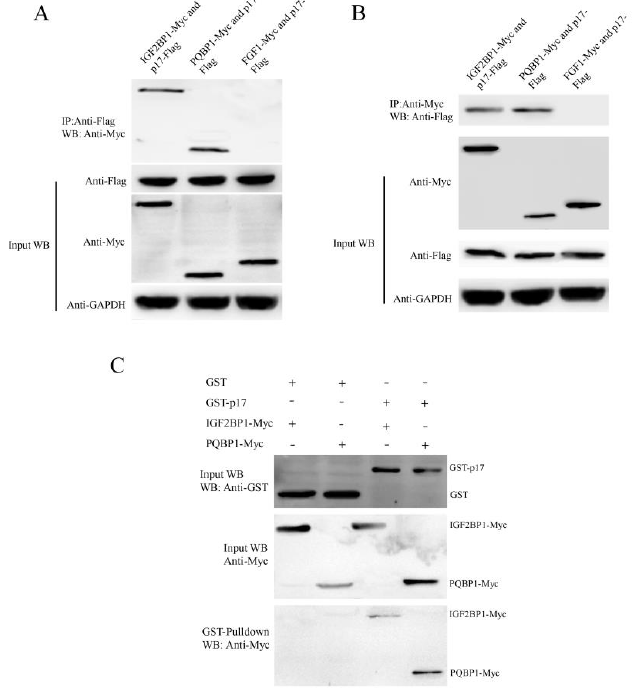
Figure 5. The ARV p17 protein interacts with PQBP1/IGF2BP1. ( A ) A coimmunoprecipitation assay demonstrated that p17-Flag bound to IGF2BP1-Myc and PQBP1-Myc but not to FGF1-Myc in cotransfected cells. Vero cells were transfected with p17-Flag and IGF2BP1-Myc or PQBP1-Myc plasmids for 36 h and then harvested. Cell lysates were immunoprecipitated with an antibody against Flag, followed by Western blotting analysis. ( B ) Reciprocal co-IP experiments showed that the anti- Myc antibody precipitated p17-Flag. ( C ) GST pulldown assay. Glutathione beads conjugated to GST or the GST-p17 fusion protein were incubated with recombinant IGF2BP1-Myc or PQBP1-Myc protein. After washing, proteins were eluted from the beads. The IGF2BP1-Myc and PQBP1-Myc proteins were assessed by immunoblotting with an anti-Myc mAb. GST and GST-LC3 protein expression was confirmed by immunoblotting with a rabbit anti-GST